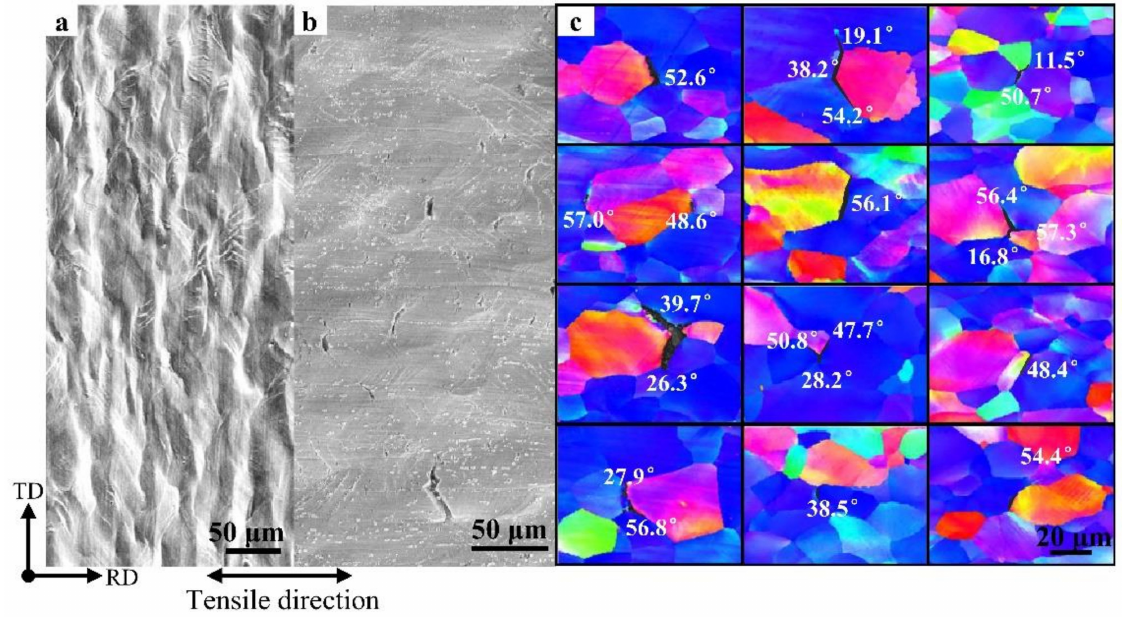
Figure 5. Crack morphology of the specimens on the surface of RD-TD; ( a ) hydrogen-uncharged and ( b ) hydrogen-charged; ( c ) IPF map of hydrogen-charged specimen (12 random fields), in which the numbers represent IC